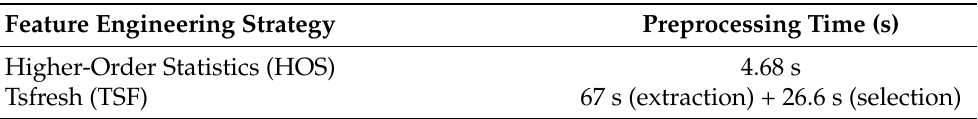
Table 3. Preprocessing time for feature engineering strategies. TSF technique requires about 20 more computational time than HOS.